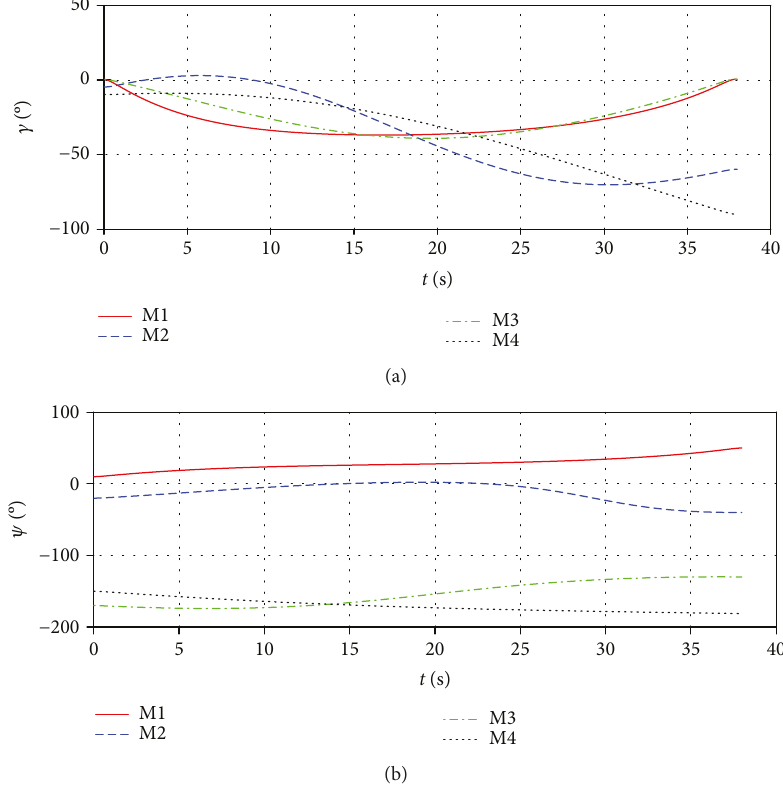
Figure 13: Curve of angles with impact time and angle control.